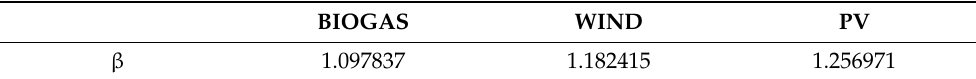
Table 3. Constant determining the relation between the source capacity and the average energy consumption by the prosumer.